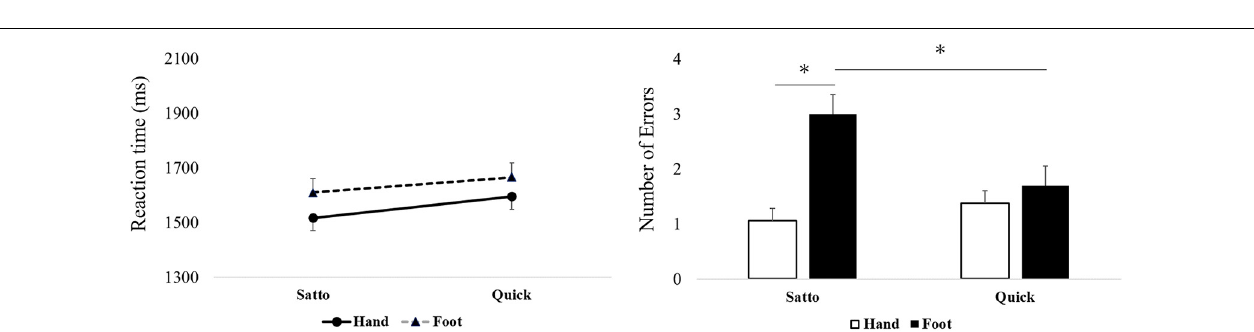
FIGURE 3 | Reaction times (RTs) and number of errors (NoE) in “Satto or Quick” and “Hand or Foot” combinations. “Hand” and “Satto” led to significantly faster RTs than “Foot” and “Quick,” respectively. Additionally, “Satto” and “Foot” had more errors than “Hand,” which was higher than “Quick and Foot” ∗ p <